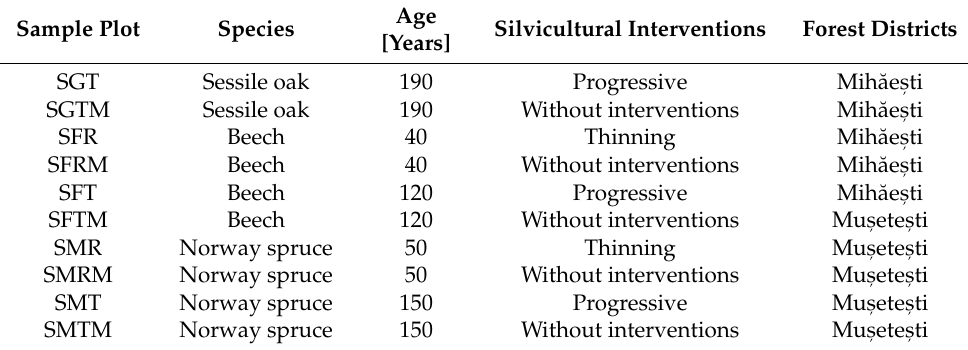
Table 1. Sample plots characteristics.